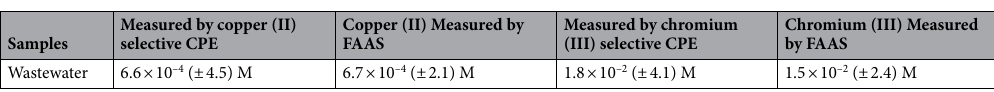
Table 4. Analysis of copper (II) and chromium (III) in wastewater samples.